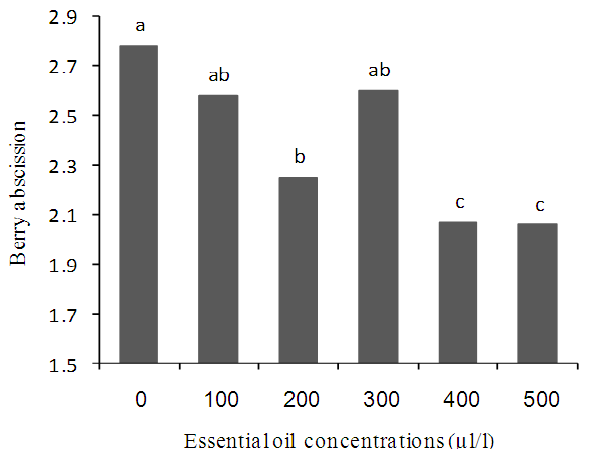
Fig. 9. The effect of essential oil treatment on dehydration of ra-